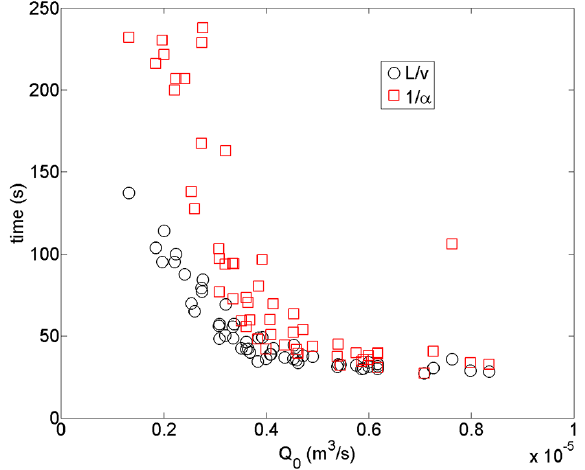
Figure 8. Transport time ( L/v ) (reciprocal of normalized velocity) and exchange time (1 /α ) (reciprocal of the exchange term) as func- tion of injection flow rate Q 0 (m 3 s − 1 ) for MIM.